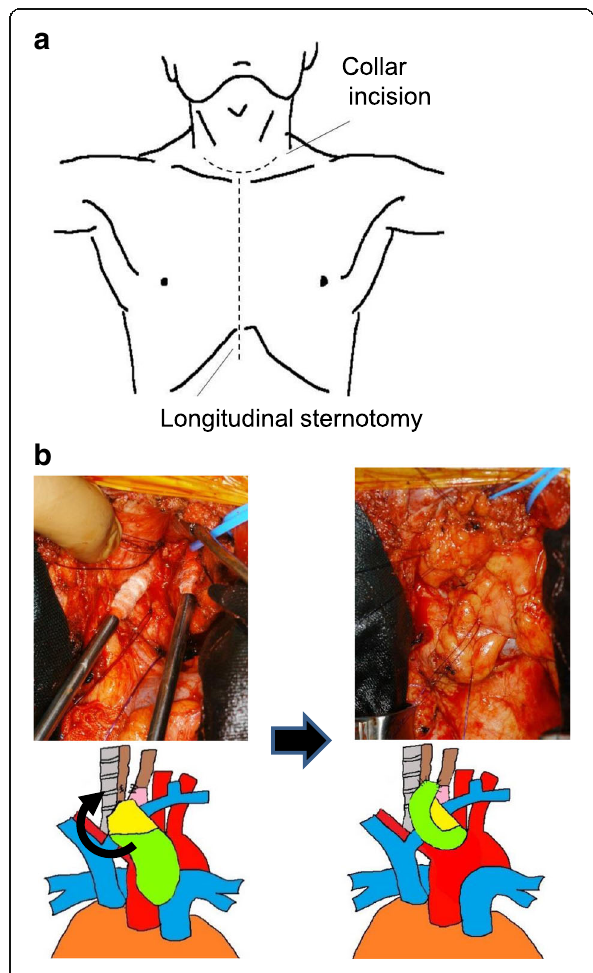
Fig. 3 Details of surgery for tracheoesophageal fistula (TEF). a The schema of the incision line. b The intraoperative findings and schemas. The thymus flap (light green) was sutured on the esophagus